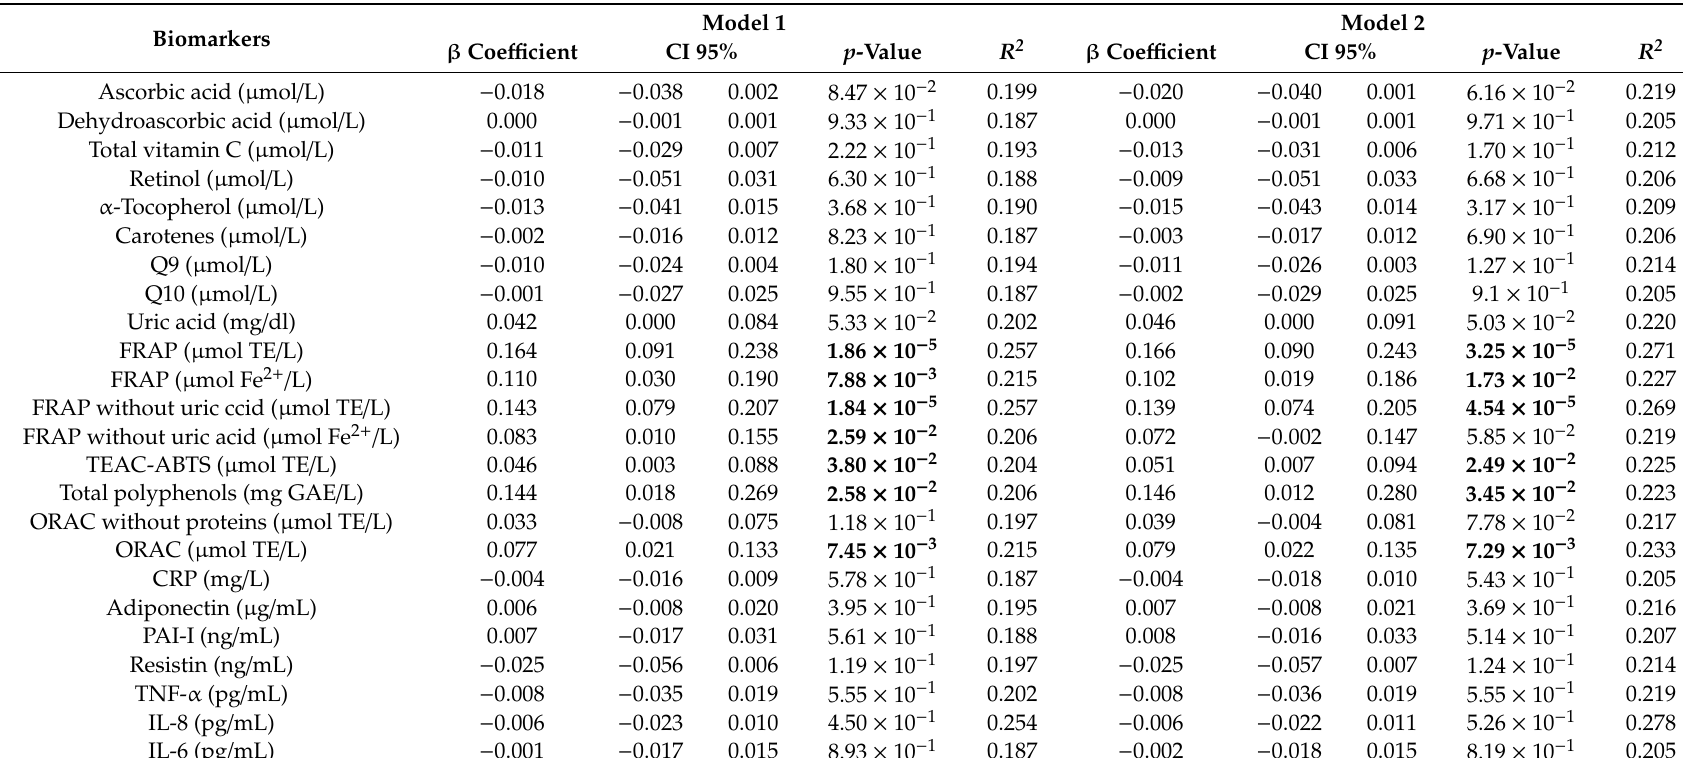
Table 3. Association between P-NEAC as TRAP and the nutrient / inflammation biomarkers in the EPIC Granada–Gipuzkoa cohort sub-sample ( n = 210).